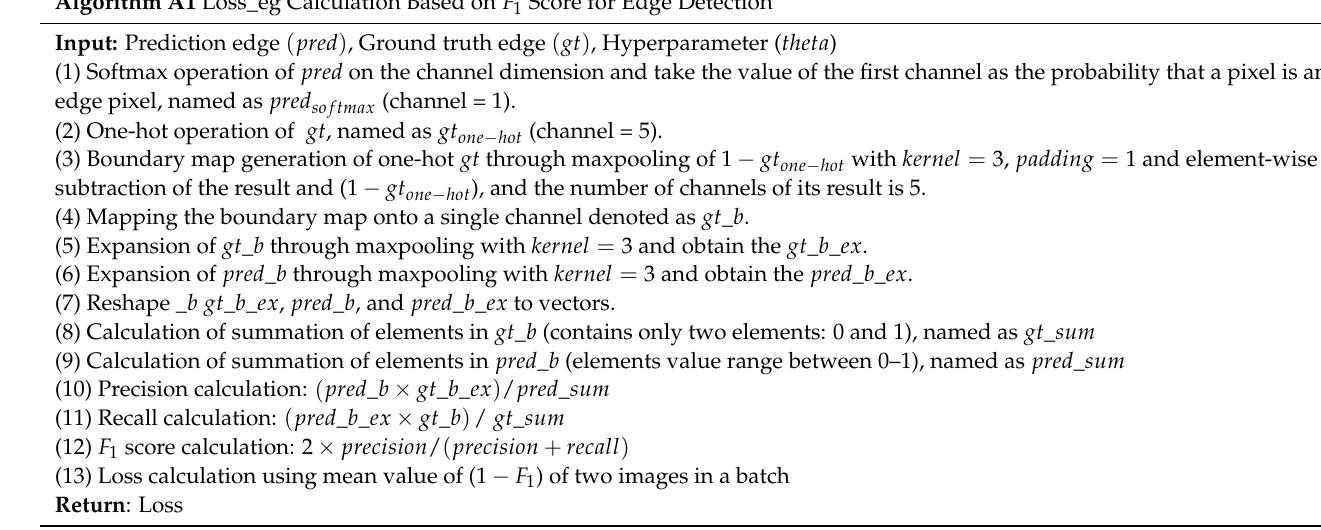
Algorithm A1 Loss_eg Calculation Based on F 1 Score for Edge Detection